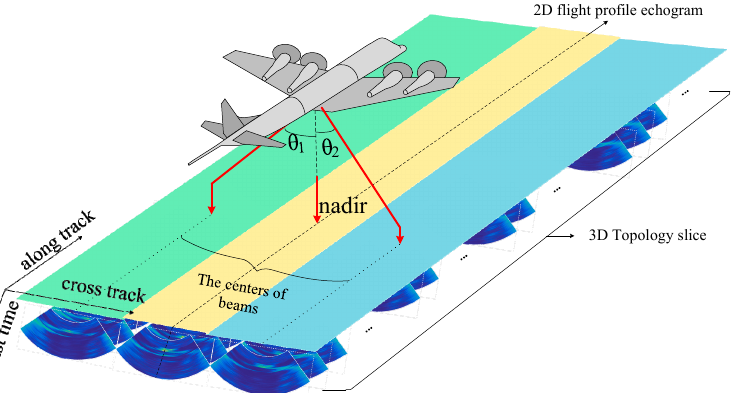
Figure 2. Illustration of the imaging process of the MCoRDS. The topology slices are collected by three beams emitted by the MCoRDS. The flight direction of the aircraft is the along-track direction (range line), the cross-track direction (elevation angle bin) is perpendicular to the along-track direction and the fast-time axis (range bin) is perpendicular to both the along-rack direction and the cross-track direction. The radar topology sequence [41] collected by the MCoRDS is shown in Figures 3 and 4.